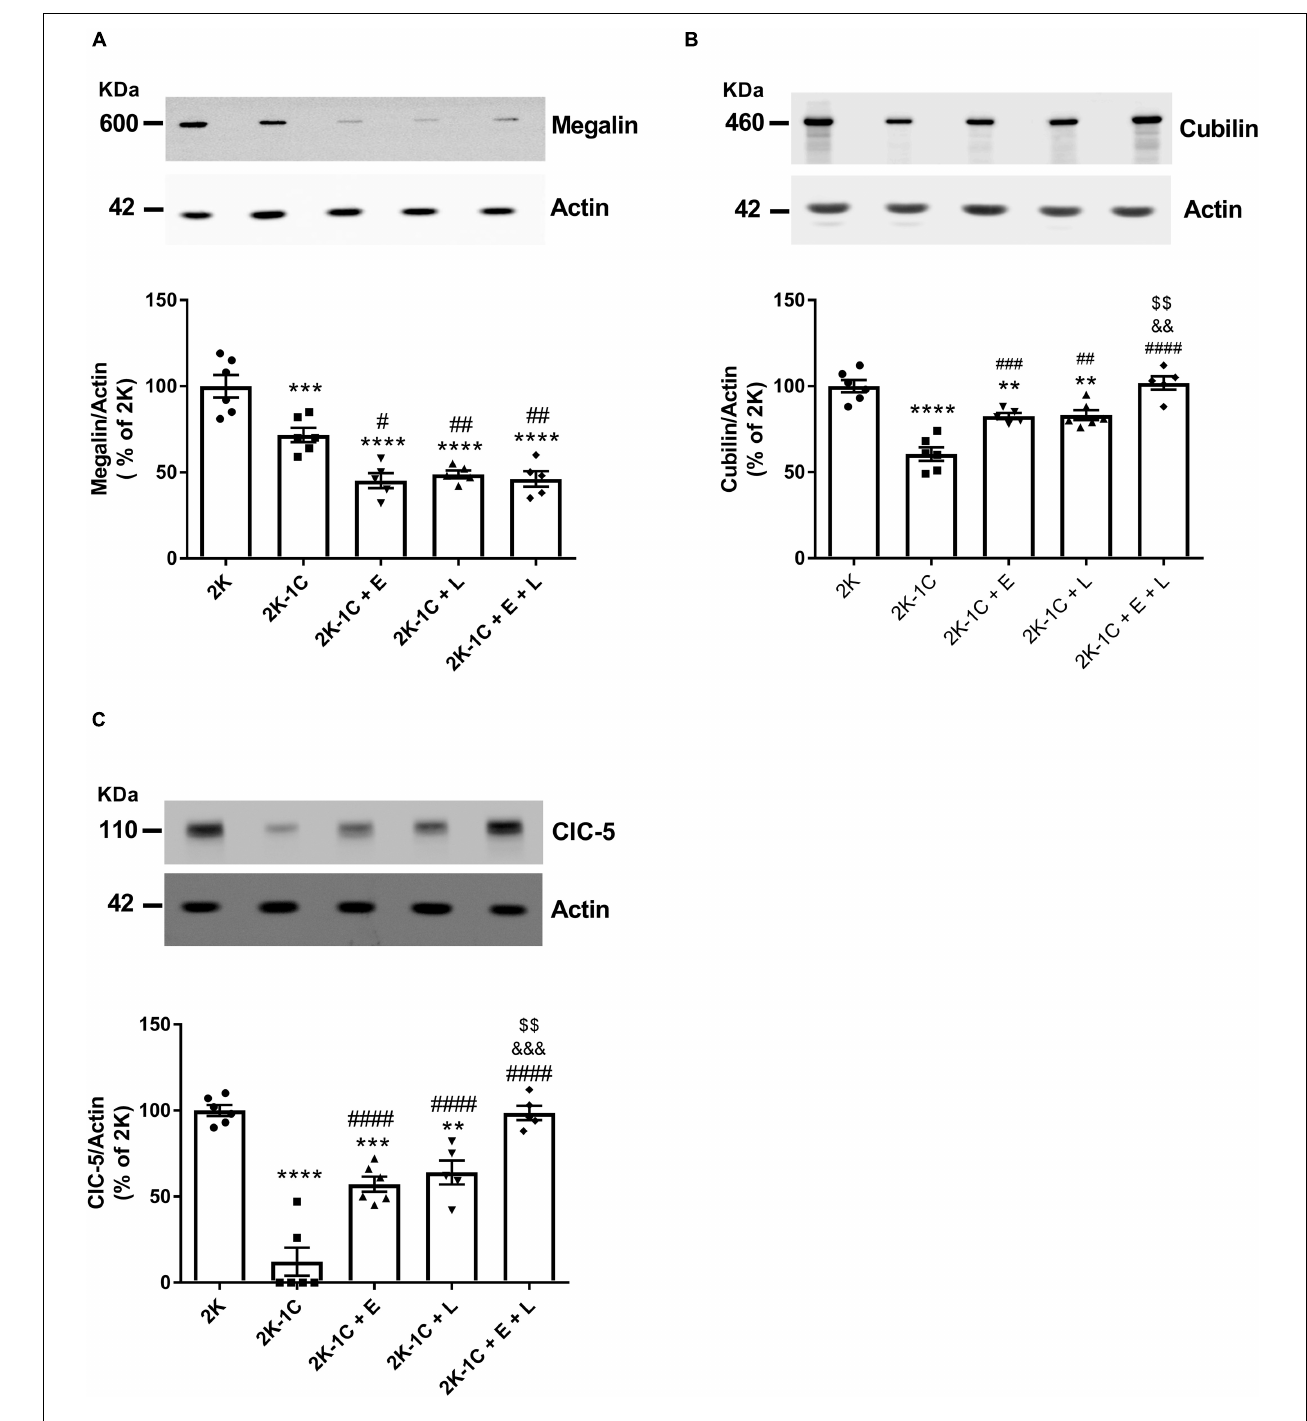
FIGURE 4 | Effect of dual versus single RAS blockade on the expression of selected key components of the proximal tubular endocytic machinery in the non-clipped kidney of renovascular hypertensive rats. Samples isolated from the non-clipped kidney of renovascular-hypertensive rats treated with enalapril (2K-1C + E, 20 mg/kg/day), losartan (2K-1C + L, 30 mg/kg/day), enalapril plus losartan (2K-1C + E + L, 30 and 20 mg/kg/day, respectively), or vehicle (2K-1C) and vehicle-treated control rats (2K) containing equal amounts of membrane proteins (10 µ g for megalin, 20 µ g for cubilin and ClC-5 nephrin and 5 µ g for actin) were subjected to SDS-PAGE, after which the proteins were transferred to a PVDF membrane and incubated with primary antibodies. Actin was used as a loading control. Representative immunoblots of electrophoresed renal membrane proteins and graphical representation of the relative expression of (A) megalin, (B) cubilin, and (C) ClC-5. The values represent individual measurements and the means ± SEM. ** P < 0.01, *** P < 0.001, and **** P < 0.0001 vs. 2K; # P < 0.05, ## P < 0.01, ### P < 0.001, and #### P < 0.0001 vs. 2K-1C; && P < 0.01 and &&& P < 0.001 vs. 2K-1C + E; $$ P < 0.01 vs. 2K-1C + L.